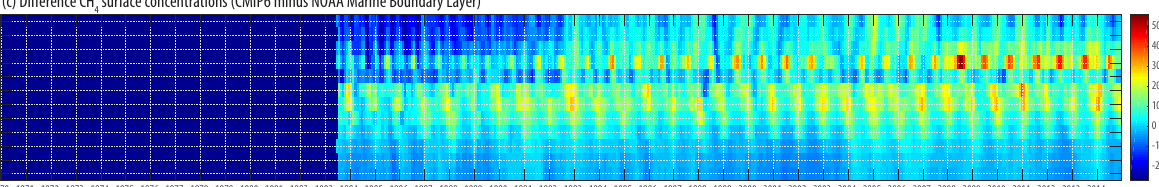
Table 11. Exponents “s” to estimate vertical gradient of concentrations for gases with stratospheric sinks in the stratospheric column – depending on the latitude “lat”. See text. For HFC-134a and other species with stratospheric lifetimes shorter than 30 years, the CH 4 exponent parameterization can be used as approximation. This exponent scale parameterization is taken from the CESM, implemented by J. Kiehl.